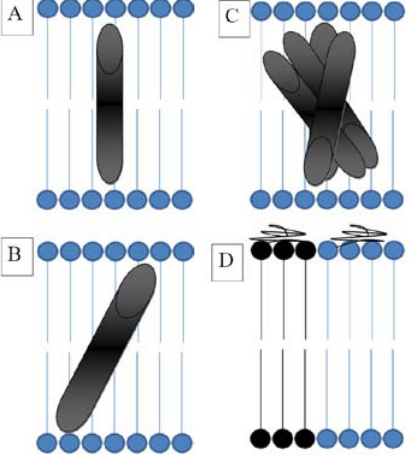
Figure 7. The author’s rendition of a bilayer membrane under various conditions. A.; a protein diffusing under “normal” conditions will exhibit a characteristic diffusion coefficient (D) value, B; a protein under the hydrophobic mismatch will tilt and consequently exhibit a lower D value than the corresponding protein in A, C; Protein aggregates, which will diffuse more slowly and hence have lower D values than a non aggregated protein in A, and D; the effect of domains, such as lipid rafts, will affect the diffusion of adsorbed DNA causing it to have a different D value when diffusing in the domain regions. The panel C of the figure illustrates protein aggregates, and we refer to the diffusion of β-amyloid peptide aggregates as reported in the study by Edwin et al. [70]. Assuming that the panel A represents the monomeric Aβ peptide at pH 7.4 with a D value of 155 µm 2 /s, the panel C corresponds to aggregates at pH 2.7 with a D value of ~3.5 µm 2 /s [70]. The panel D illustrates the diffusion of membrane-adsorbed DNA oligonucleotides in different membrane lipid domains (black and blue). After Athmakuri et al. [71]. D values will depend on the area of the membrane. The authors report a D value of 1.67 µm 2 /s under conditions where DSPC membrane composition was 10%, while the diffusion coefficient decreased to 0.14 µm 2 /s when DSPC % was equal to 50. The presence of DSPC domains resulted in decreased diffusivity of adsorbed DNA oligonucleotides